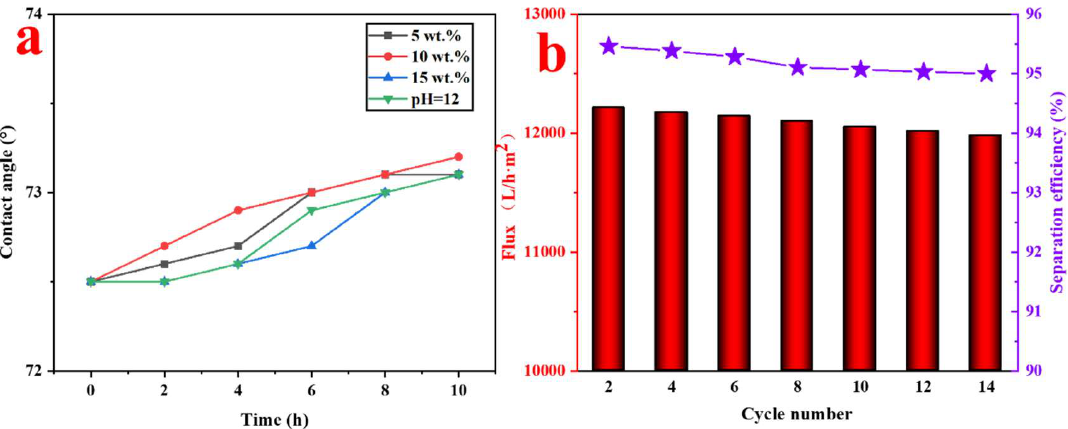
Figure 13. ( a ) PPS/ZIF-8 fiber membranes’ resistance to high alkali and salt solutions; ( b ) recycling performance of PPS/ZIF-8 fiber membranes.